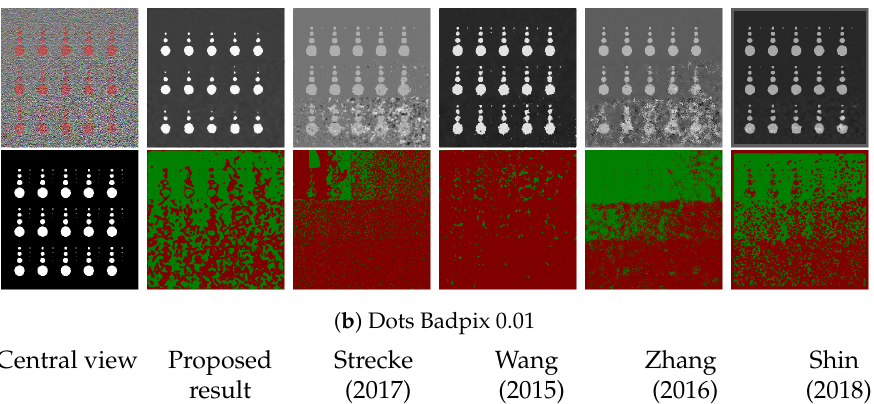
Figure 23. Visual comparison of the ground truth with the proposed algorithm, Strecke et al. [9],